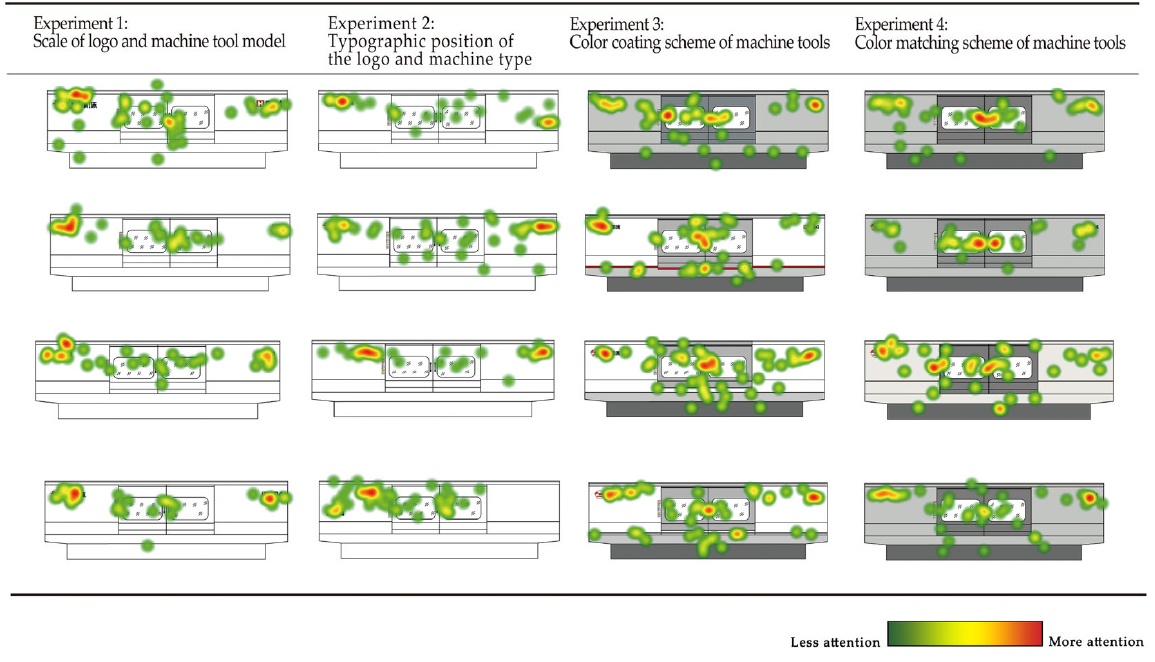
Figure 4. Illustration of the user ‐ focused area.